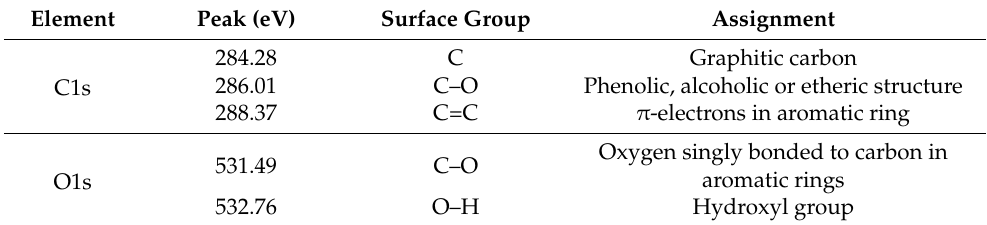
Table 2. The assignment of the XPS peaks of AC based on WRN.